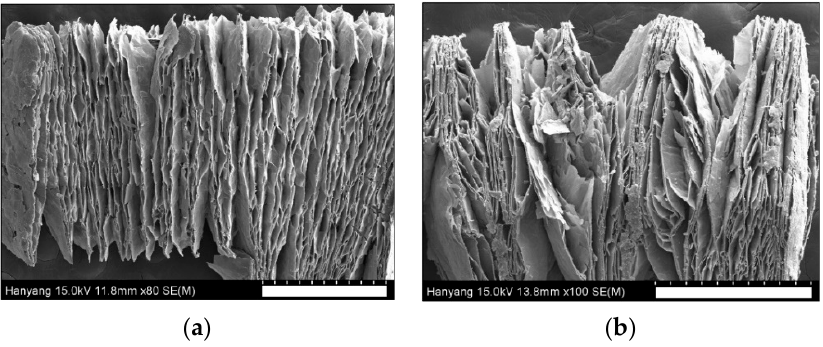
Figure 4. SEM images of Palabora vermiculite expanded by ( a ) H 2 O 2 treatment followed by microwave drying, and ( b ) thermal treatment at 1000 °C. The white scale bars correspond to 500 µm. Table 2. Chemical compositions of raw Palabora vermiculite analyzed by XRF.